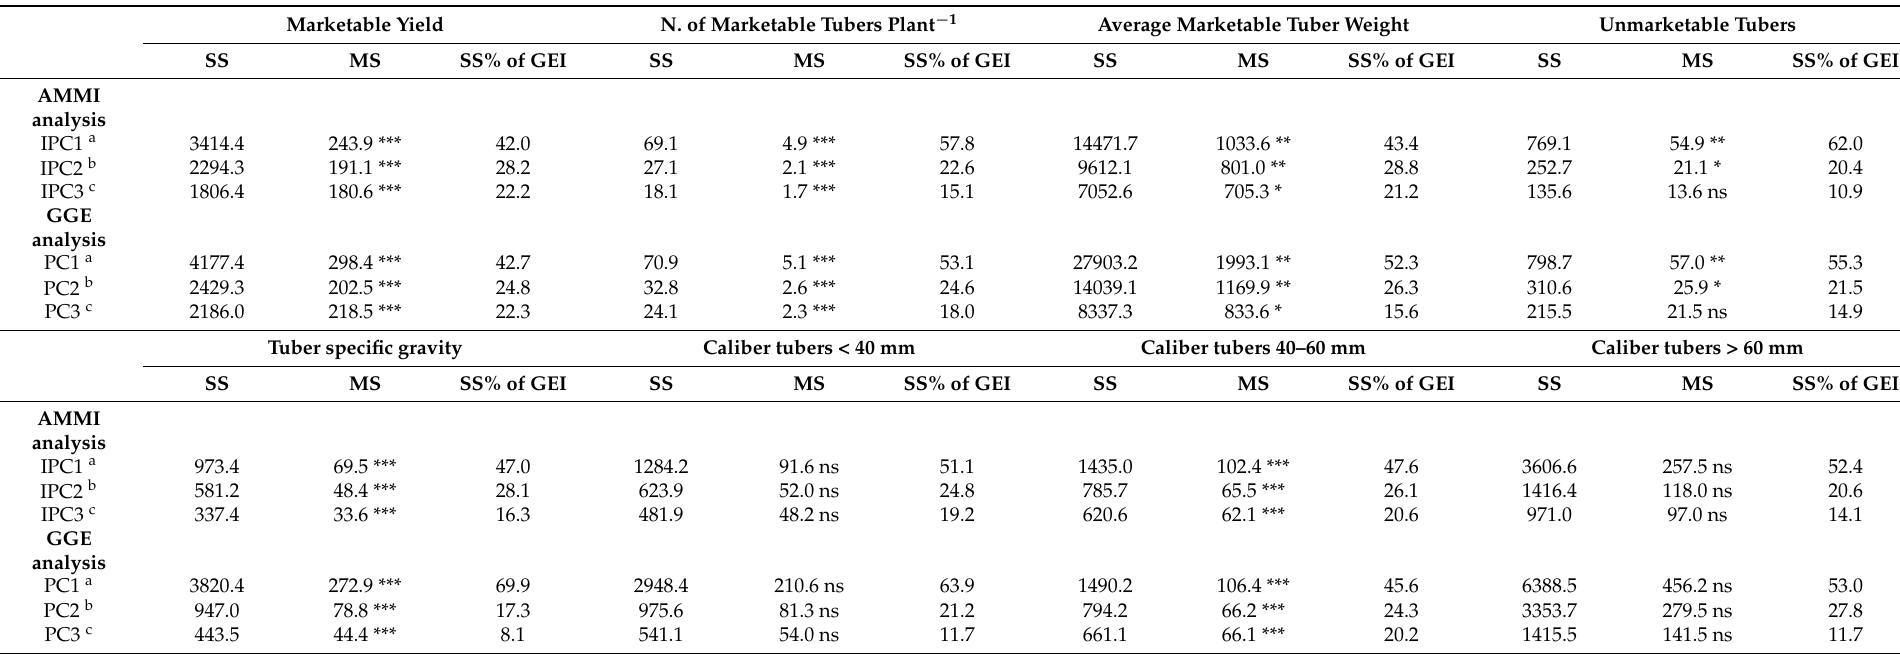
Table 3. Additive main effects and multiplicative interaction (AMMI) and G + GE (GGE) analyses in potato yield and yield